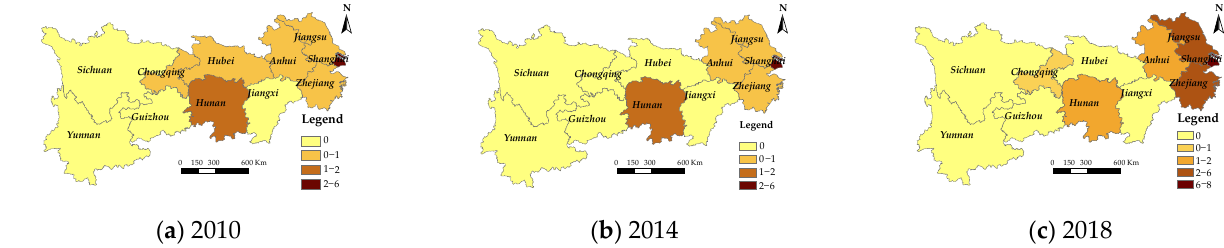
Figure 4. Comparison of distribution of China’s top 100 OFDI enterprises in the Yangtze River Economic Belt (by number).